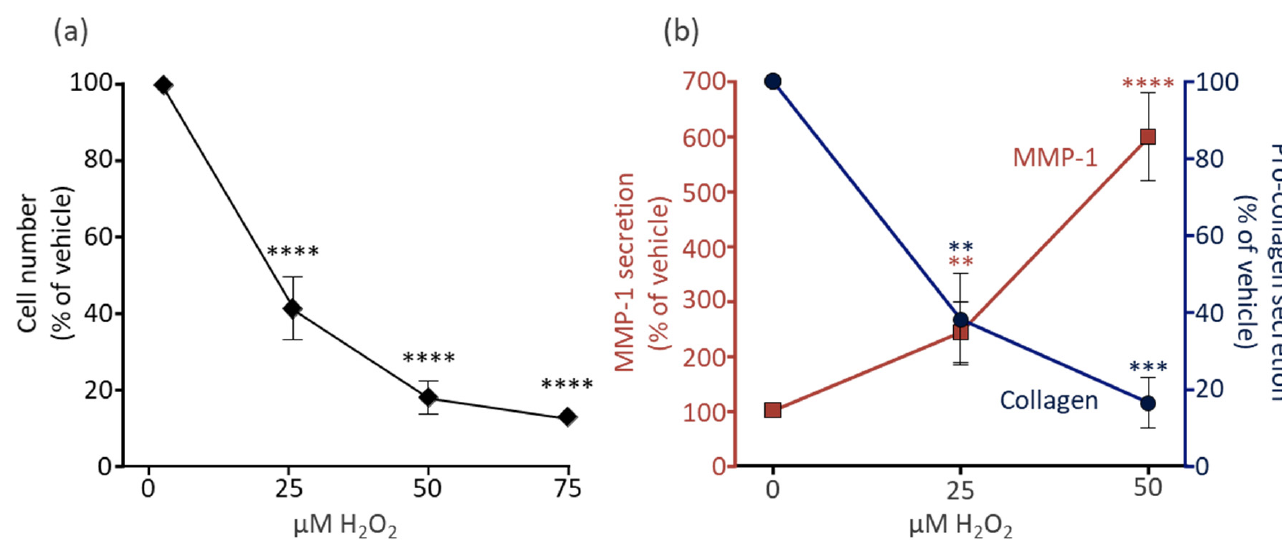
Figure 1. NHDF cells were seeded in 96-well plates (10 4 cells/well). Twenty-four hours later, the cells were incubated with the indicated concentrations of H 2 O 2 for 24 h. ( a ) The cell number was determined by the XTT method as described in Section 2.3. ( b ) Secretion of MMP-1 and pro-collagen 1a1 were determined in the media using ELISA assays as described in Section 2.3. Results are presented as a percent of the values without H 2 O 2 . Y-axis scales: 100% of the cell number was 35,534 ± 1251 cells/well; 100% of the MMP-1 secretion was 47 ± 12 pmol per 1000 cells; 100% of the pro-collagen secretion was 107 ± 60 pmol per 1000 cells. Values are the means ± SEM of 3–5 experiments, each performed in triplicate. ** p < 0.01, *** p < 0.001, **** p < 0.0001, significant difference between the vehicle with and without H 2 O 2